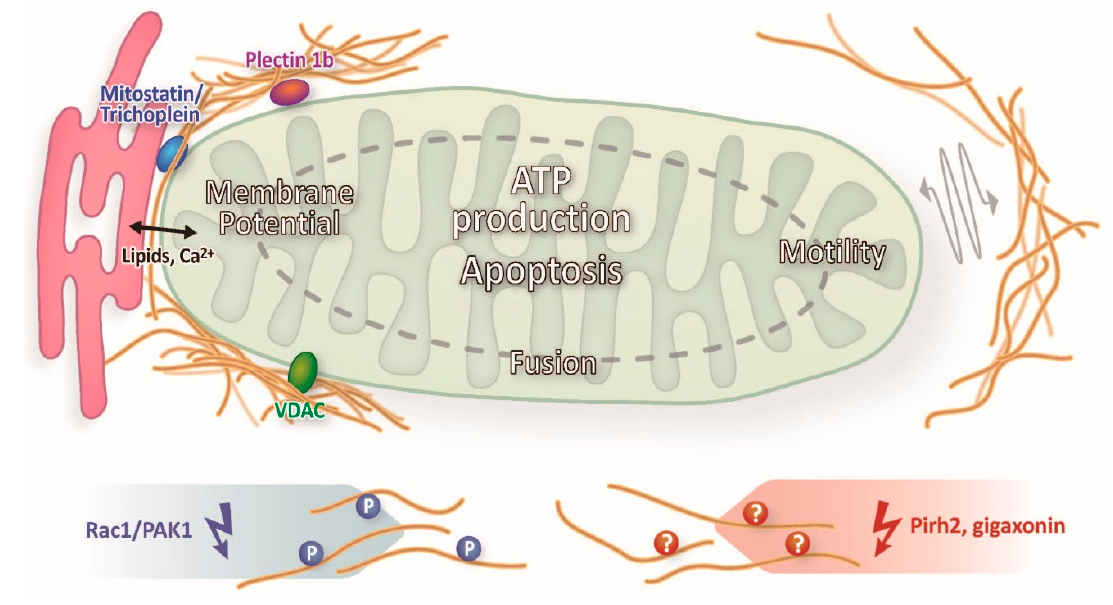
Figure 2. Schematic synopsis of different modes of interaction between intermediate filaments and mitochondria and their consequences as described in this review.